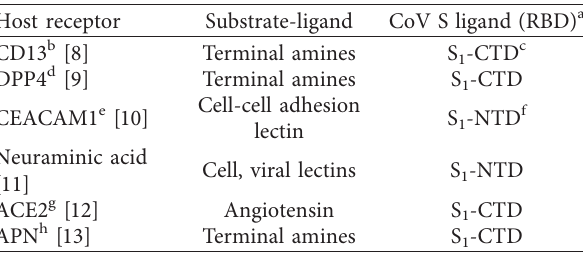
Figure 1: Schematic of the CoV S protein primary structure and cleavage sites. Arrows indicate cleavage sites (S 1 /S 2 ) resulting in S 1 and S 2 � fusion peptide; HR1 and HR2 � heptad repeat regions 1 and 2; ′ ) located in the S subunits with a cleavage site (S 2 subunit. FP 2 binding motif; SP � signal peptide. Taken from Depfenhart, M., de Villiers, D., Lemperle, G., et al., Inter. Emerg. Med., vol. 15, pp. 801–812, Table 1: CoV S protein recognition elements. Table 2: Overview-SARS-CoV-2 S protein